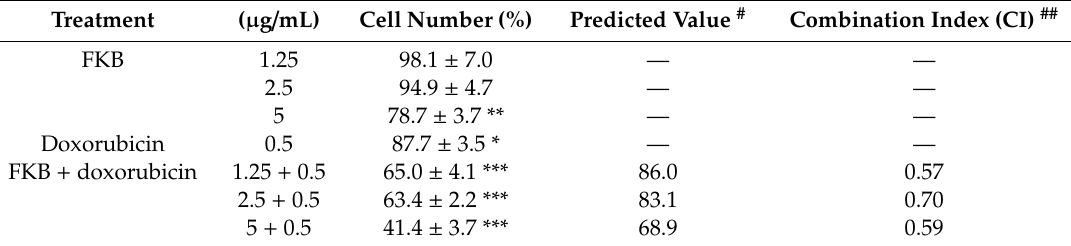
Table 3. The synergism e ff ects of FKB and doxorubicin on MKN45 cells.